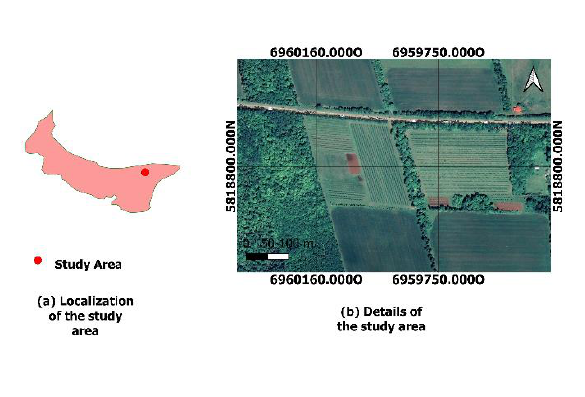
Figure 4 . The study area used in this research.